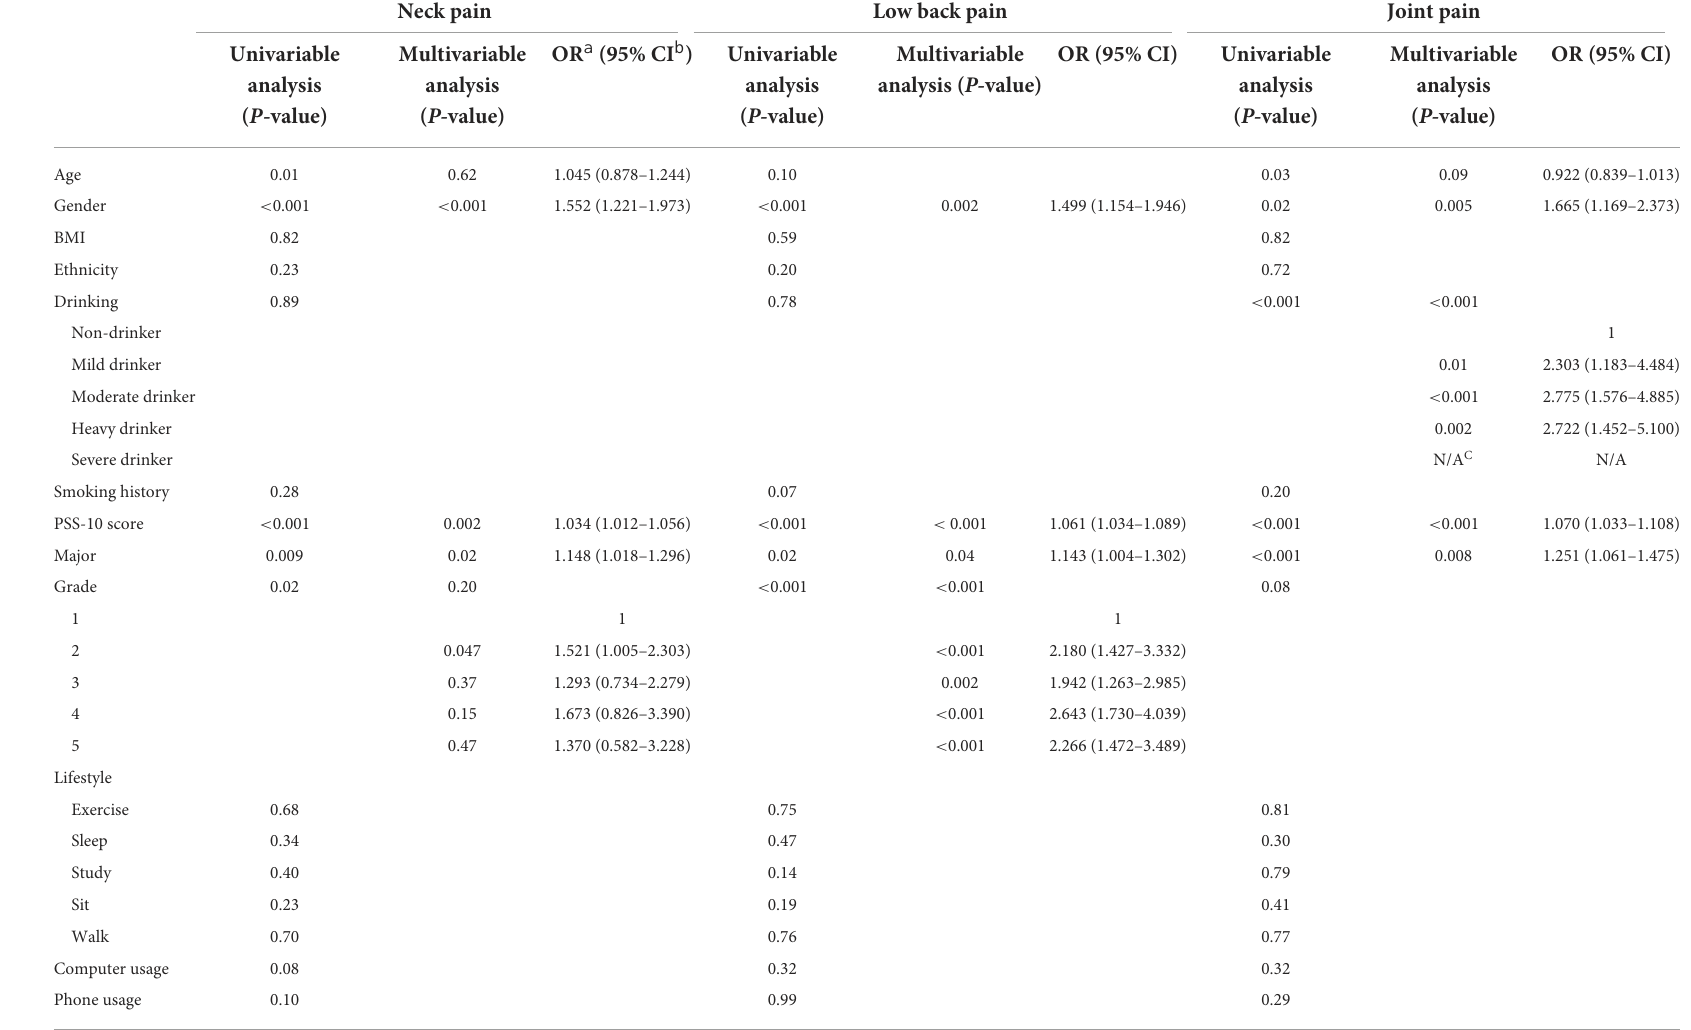
TABLE 3 Risk factors of musculoskeletal pain in medical and dental